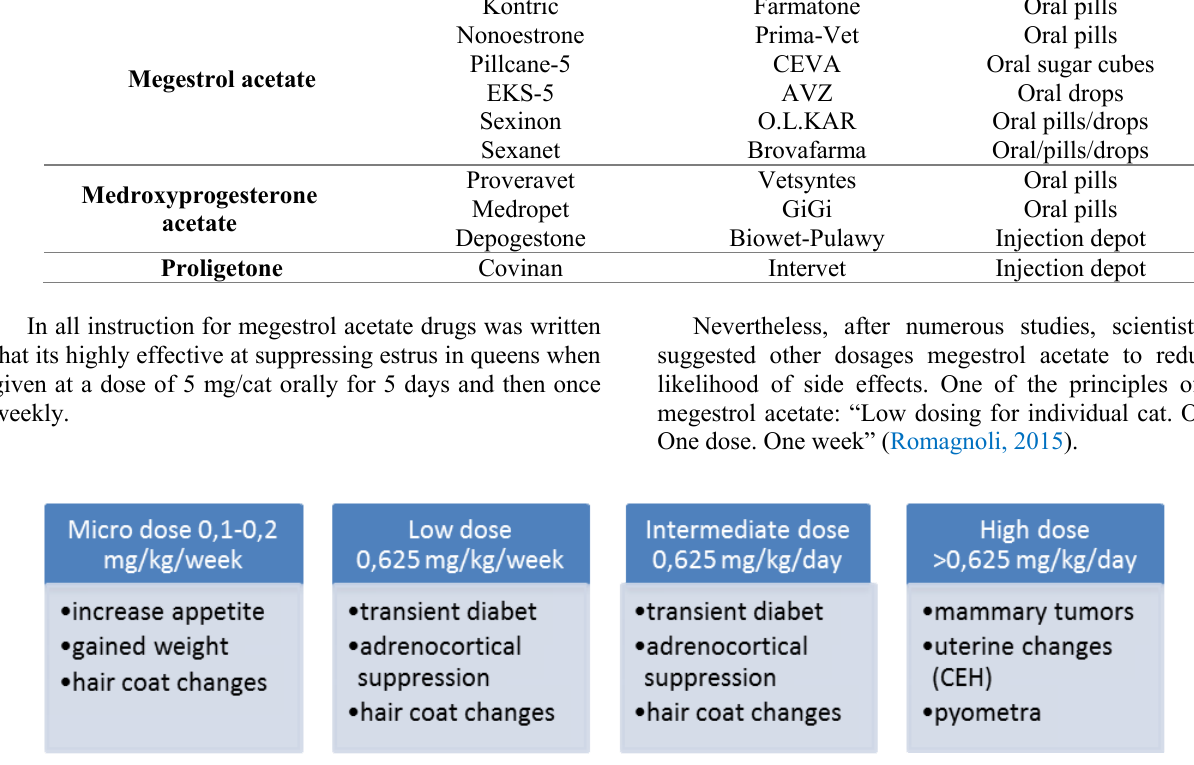
Most popular and commercially available in Ukraine progestin contraceptives Contraceptive